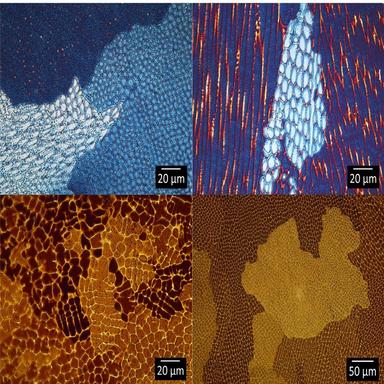
Representative sample images of AM316L microstructure that show the wide variation of its feature characteristics.